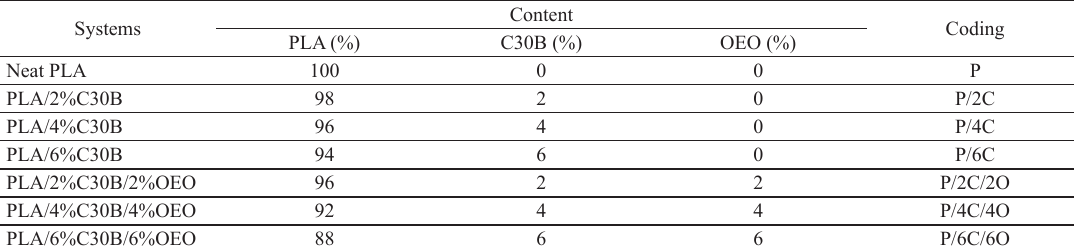
Table 1. Systems produced and respective